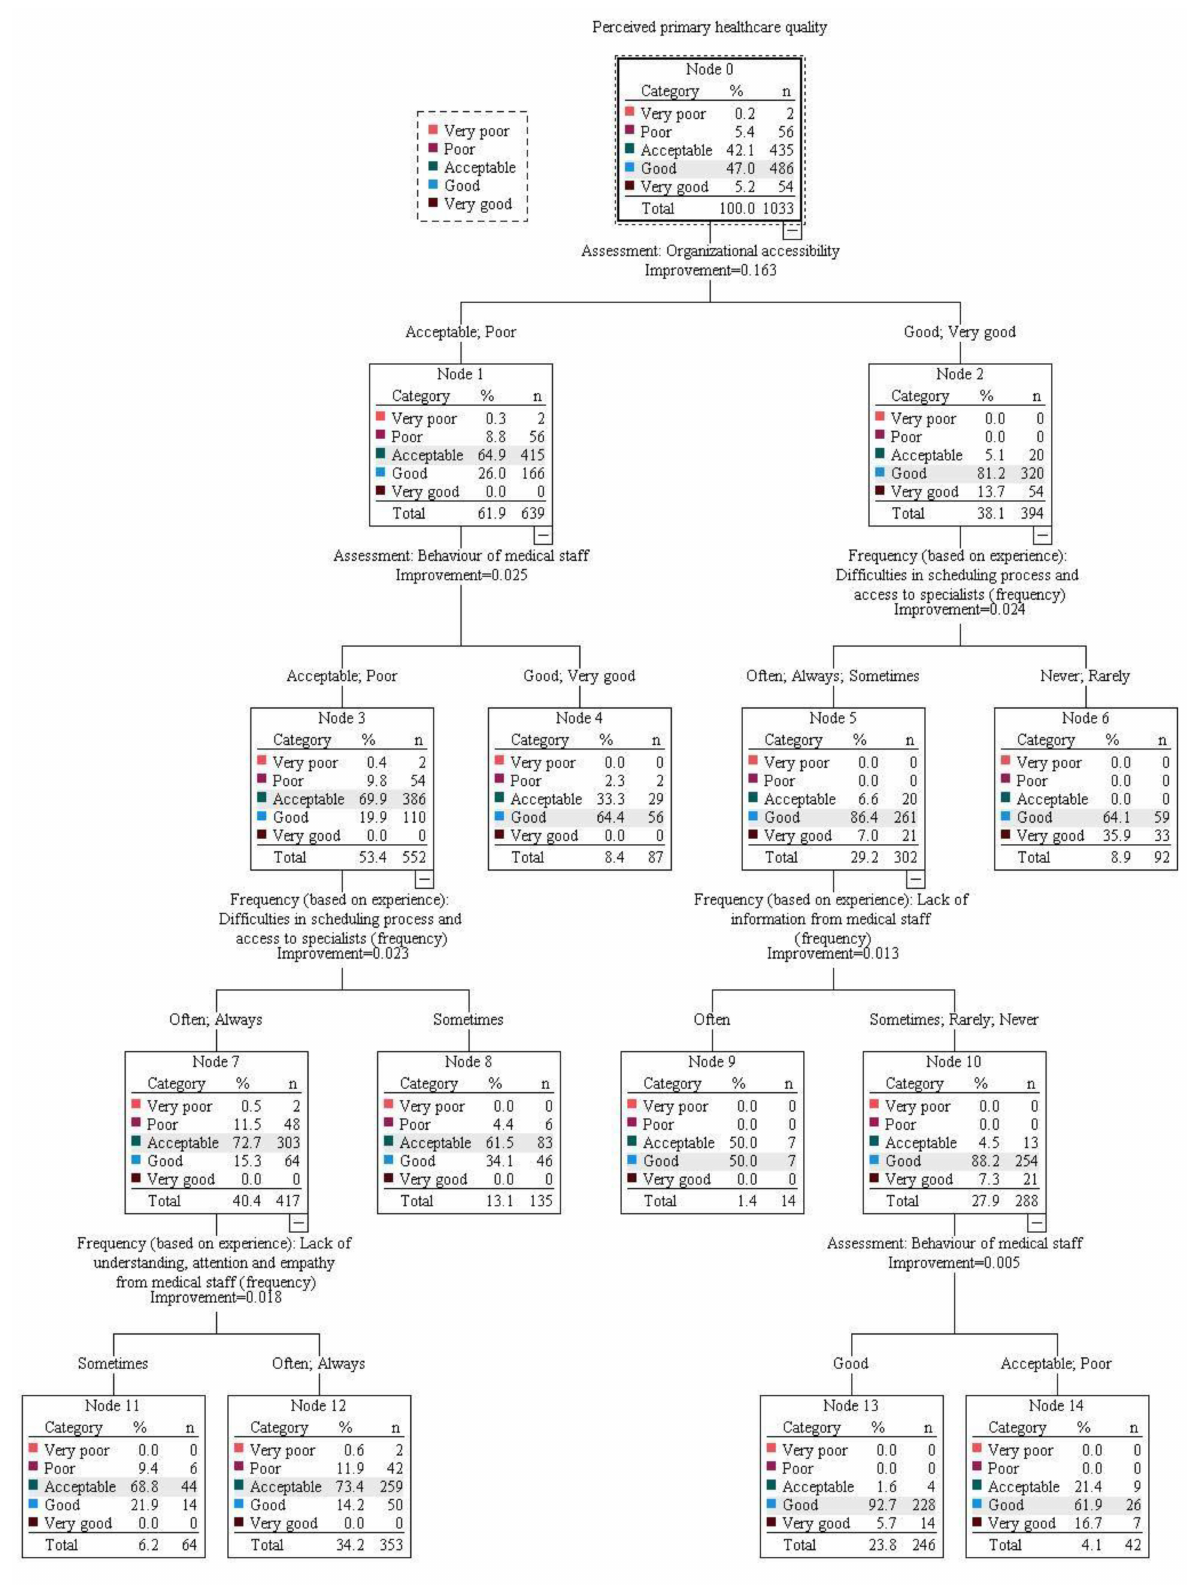
Figure A2. CRT model